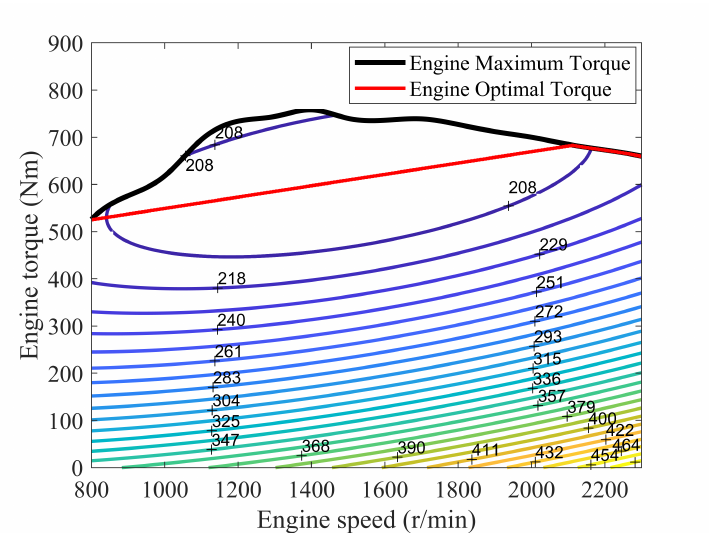
Figure 2. Engine fuel consumption MAP.